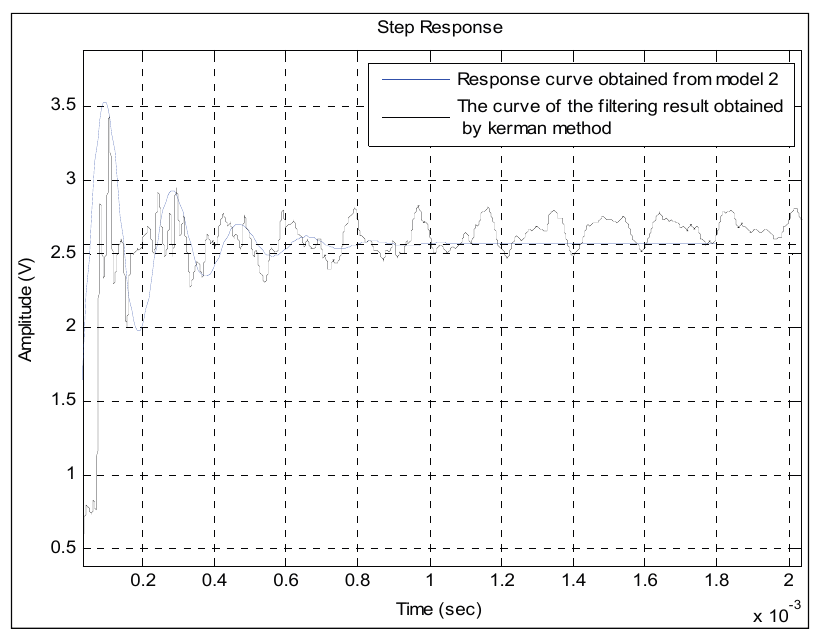
Figure 10. Comparison between the step response obtained from Model 2 and the curve of the filtering result obtained by the Kalman